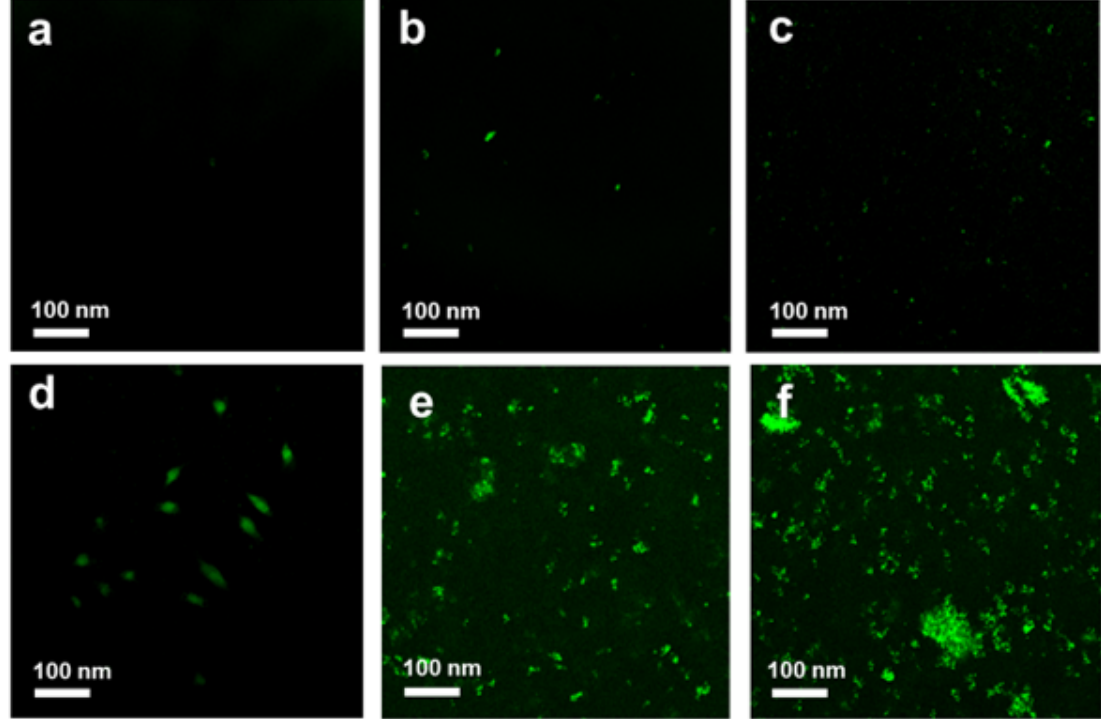
Figure 14. ROS fluorescence images of control S. aureus ( a ) and S. aureus treated with GO ( b ), Ag NPs ( c ), Ag NPrsms ( d ), GO–Ag NPs ( e ), and GO–Ag NPrsms ( f ) stained with DCFH-DA. The GO–Ag NPrsms showed antibacterial activity superior to that of GO–Ag NPs.